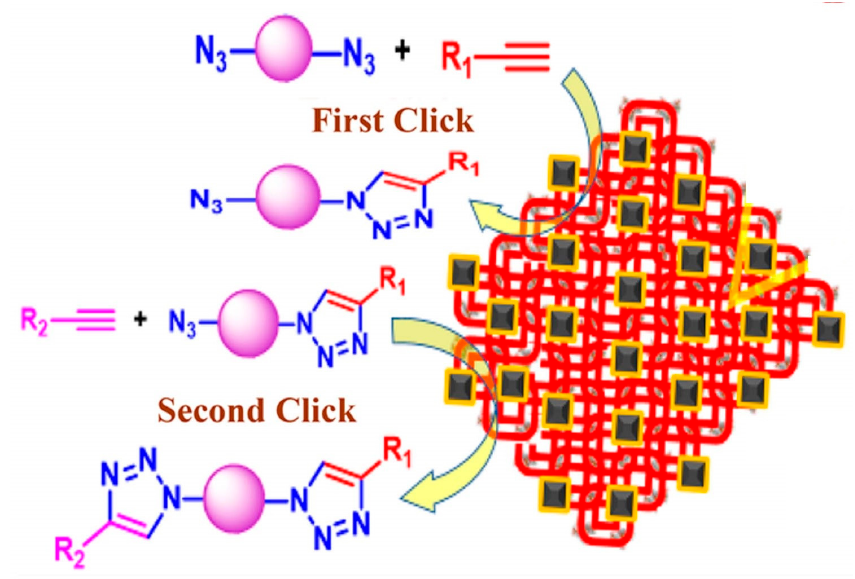
Figure 12. Synthesis of a metal–organic framework (Cu-MOF) to catalyze the CuAAC reaction in an efficient and chemoselective manner. Reproduced from [105] with permission from the American Chemical Society Copyright (2020) .